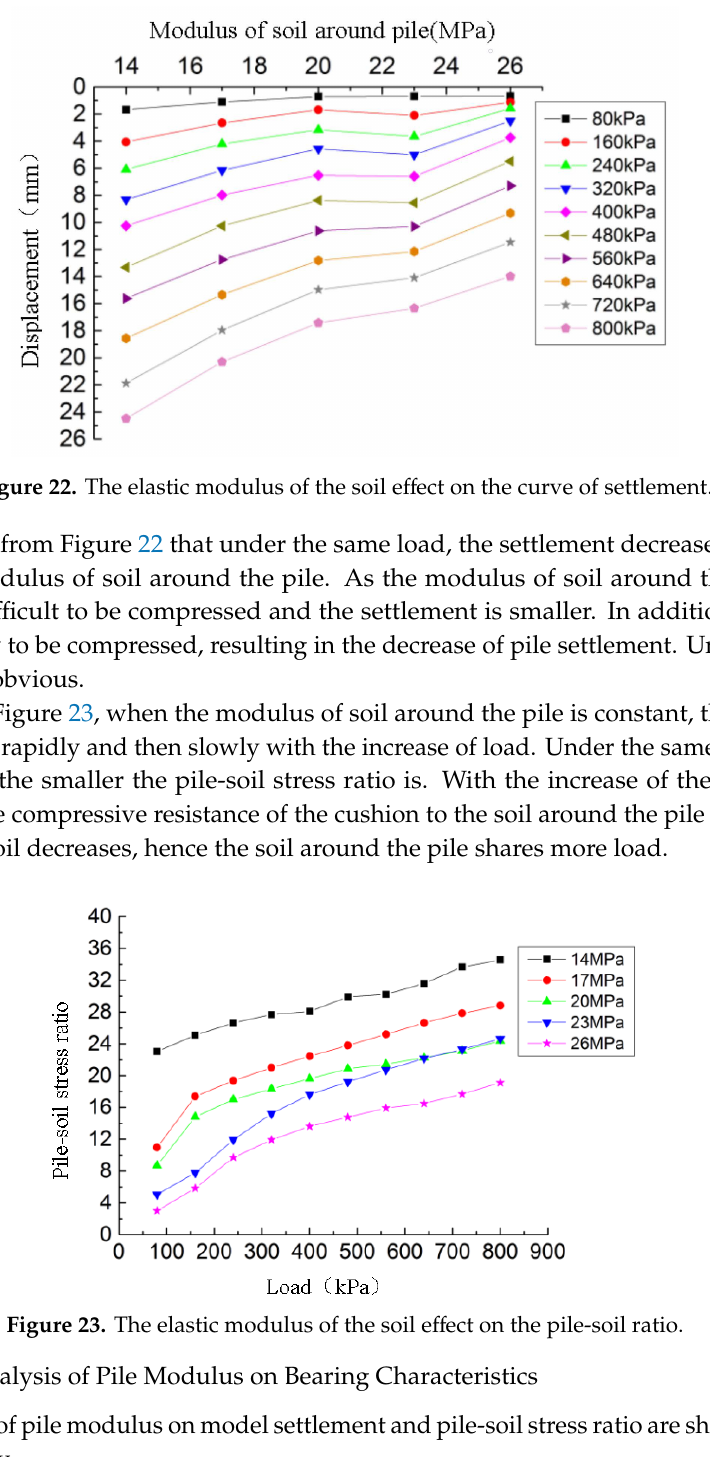
Figure 24. The elastic modulus of the pile effect on the curve of settlement.